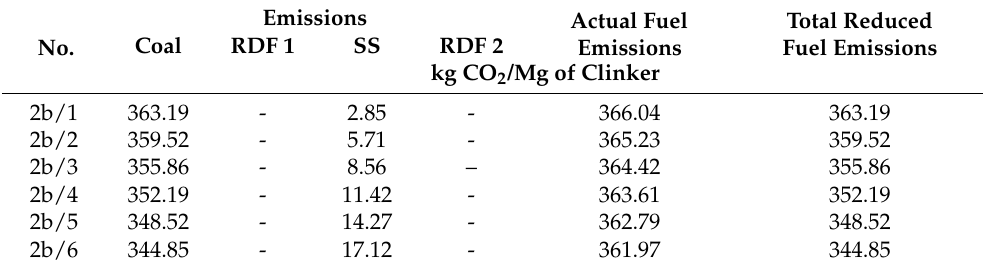
Table 6. The CO 2 emissions balance of blends of coal with SS (2b—two